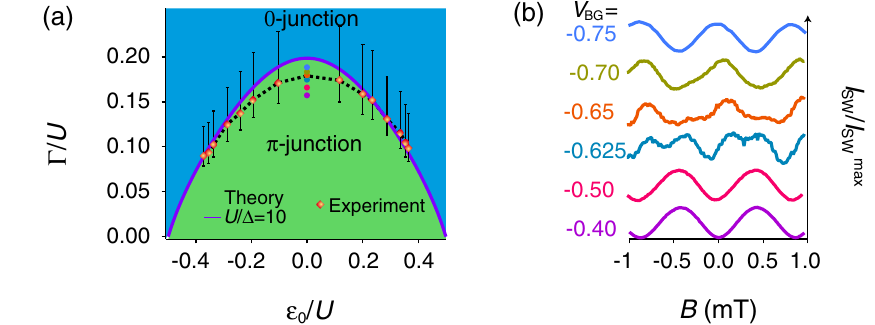
FIG. 6. 0 - (cid:1) phase transition diagram and nano-SQUID modulations. (a) The experimentally determined phase boundary between 0- and (cid:1) -junction behavior of JJ1 (orange diamonds connected by the dashed line) is given as a function of the dot energy (cid:2) 0 =U and the level width (cid:1) =U . The Coulomb repulsion U (cid:4) 0 : 8 meV is estimated from the finite-bias spectroscopy of the Coulomb-blockade diamond, and (cid:2) (cid:4) 80 (cid:6) eV from the proximity effect; see Appendix B. Error bars indicate the uncertainty in the estimate of (cid:1) from the analysis of the Kondo resonances. The purple solid line represents the theoretical phase diagram for the experimentally determined ratio U= (cid:2) ¼ 10 ; it slightly overestimates the experimental phase boundary. (b) Magnetic-field modulations of the nano-SQUID switching current taken in the middle of the odd-charge Kondo ridge [shown as the red star in Fig. 2(a)] for different backgate voltages associated with the fine mesh of dots at (cid:2) 0 ¼ 0 in panel (a). For better comparison, the switching-current modulations are all normalized to the maximum current amplitude, which is strongly suppressed in the transition region. A clear nonharmonic regime occurs near the 0 - (cid:1) phase boundary, where the bistable behavior (in phase) of the supercurrent may be attributed to the first-order transition between the 0 and (cid:1) states.